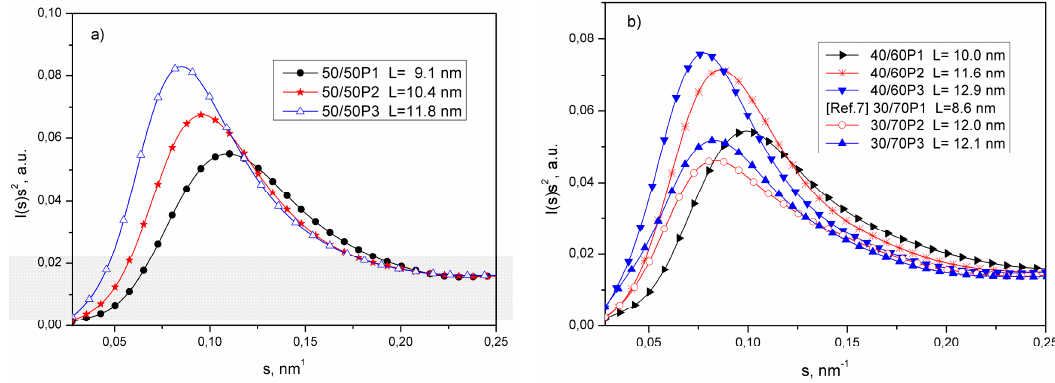
Figure 5. The Lorentz–corrected SAXS patterns at 23 °C (L—long period) for PTT/PEOT ratio of ( a ) 50/50 and ( b ) 40/60 and 30/70.